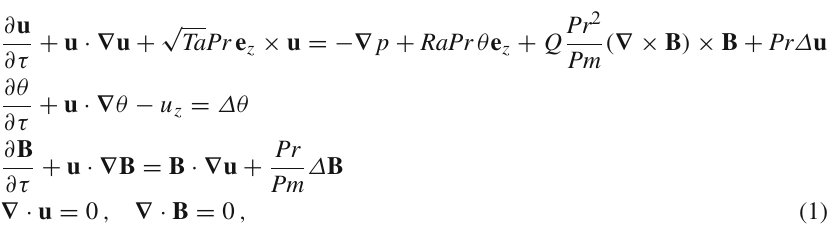
ferentially heated horizontal plates, each held at a fixed temperature. This model is derived under the Boussinesq approximation, which amounts to assuming that the flow is highly subsonic and that density perturbations δρ to a uniform and constant back- ground density ρ o are negligible everywhere except in the buoyancy term δρ g , where g = − g e z stands for the gravity (Chandrasekhar 1961). The equilibrium background state is a linear temperature profile with temperature decreasing from the bottom to the top of the layer. Anticipating discussions of the effects of rotation and magnetic fields on supergranulation, we consider the case of an electrically conducting fluid threaded by a mean vertical magnetic field denoted by B o = B o e z and rotating around a vertical axis, with a rotation rate (cid:2) = Ω e z . This set-up is pictured in Fig. 8. In nondimensional form, the equations for momentum and energy conservation, the induction equation, the equations for mass conservation and magnetic field solenoi- dality read